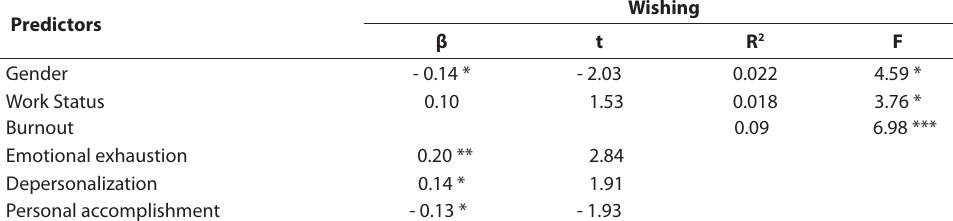
TABLE 5 Regression analysis of Wishful Thinking strategy from gender, work status and MBI-GS que- stionnaire